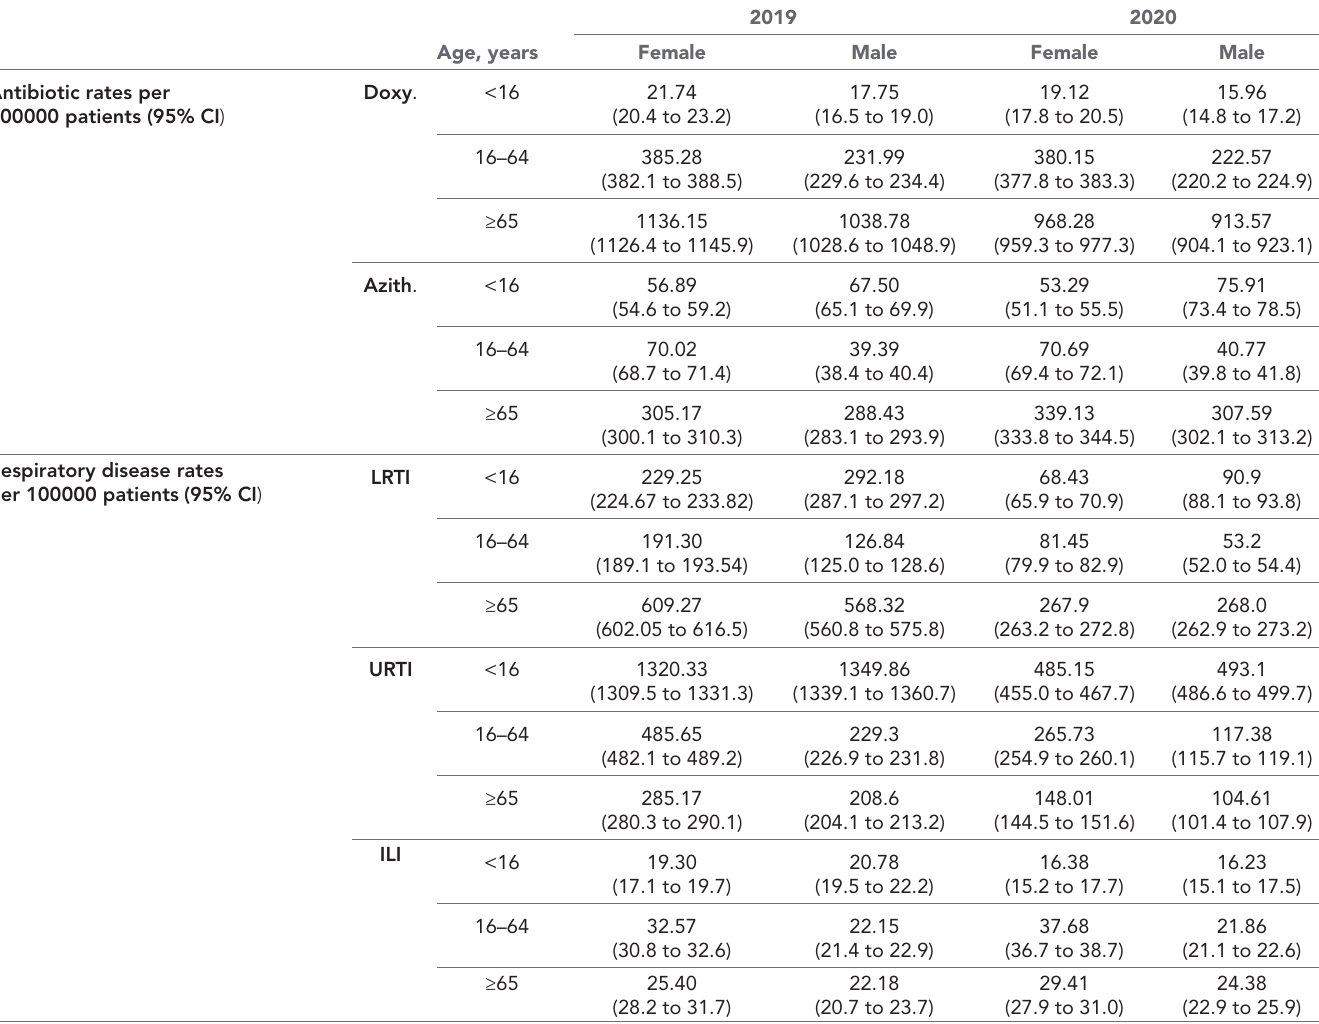
Table 1 Comparison of rates of prescription of doxycycline and azithromycin in 2020 with 2019. In people aged ≥65 years there was a decrease in doxycycline use but an increase in azithromycin prescription. Lower respiratory tract infection and upper respiratory tract infection incidence fell across all age bands and both sexes. Influenza- like illness was much more similar between years.